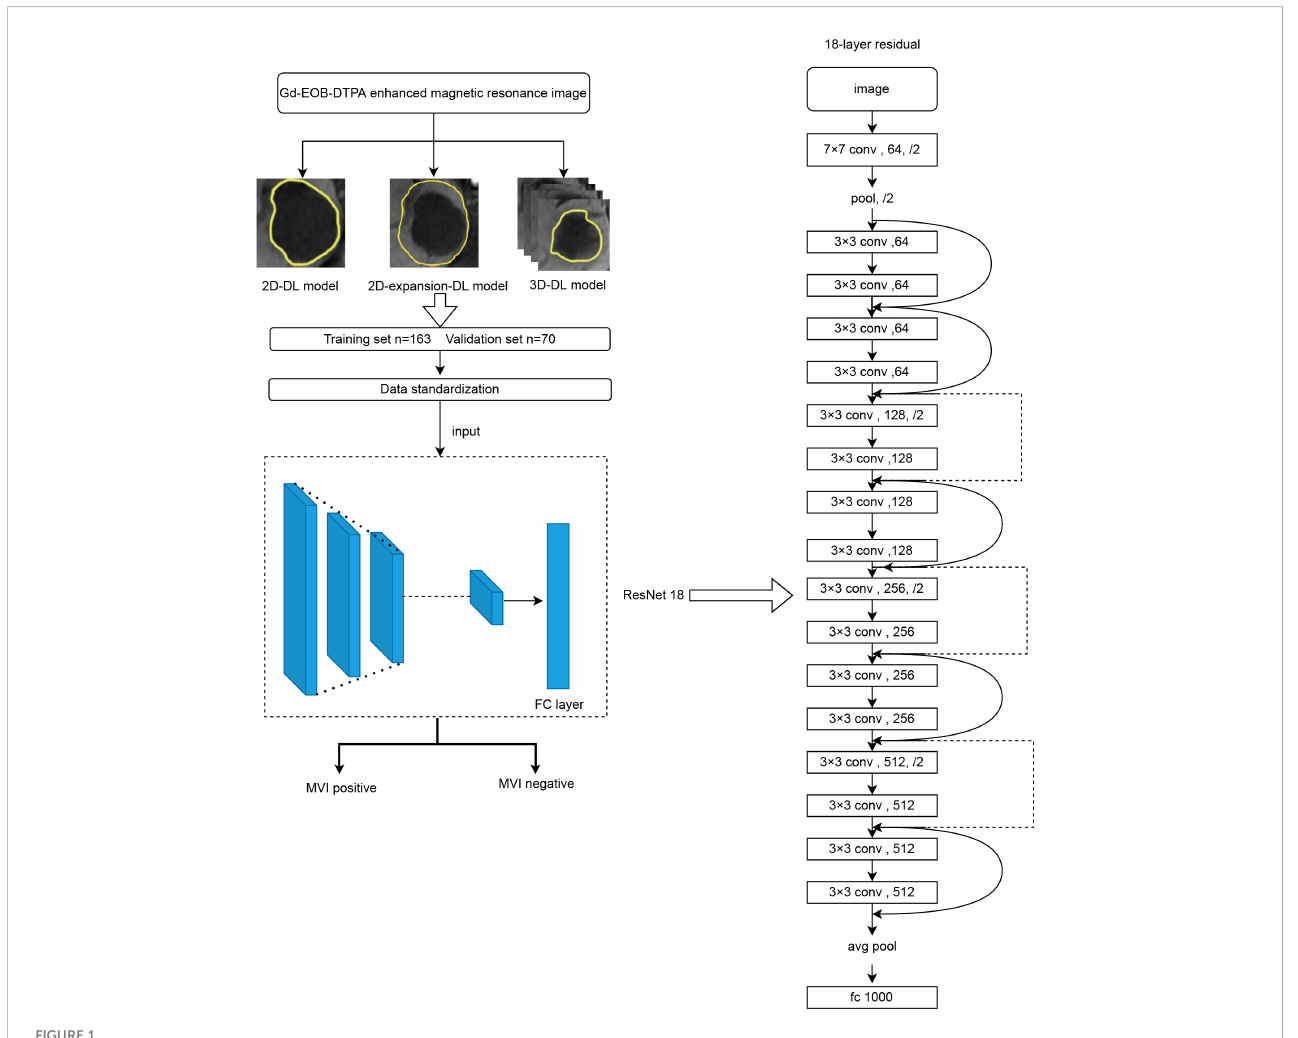
FIGURE 1 The architecture of the Deep Learning